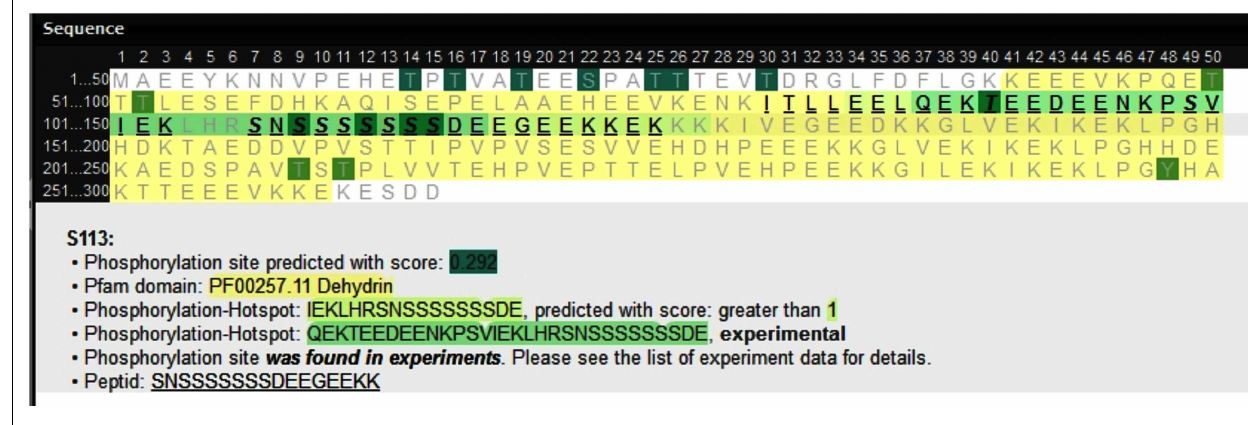
FIGURE 3 | Screenshot of the PhosPhAt database with P-hotspot annotation